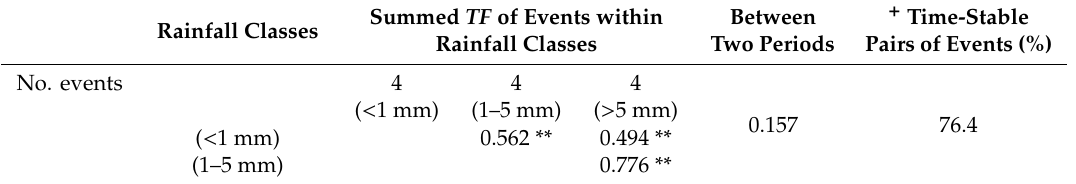
Table 1. Spearman rank correlation coe ffi cients (r s ) between the cumulative throughfall ( TF ) of rain events within rainfall classes (for the leafed period) and between the cumulative TF of leafed and leafless periods ( + time-stable pairs of events by percentage can be observed in the leafed period).